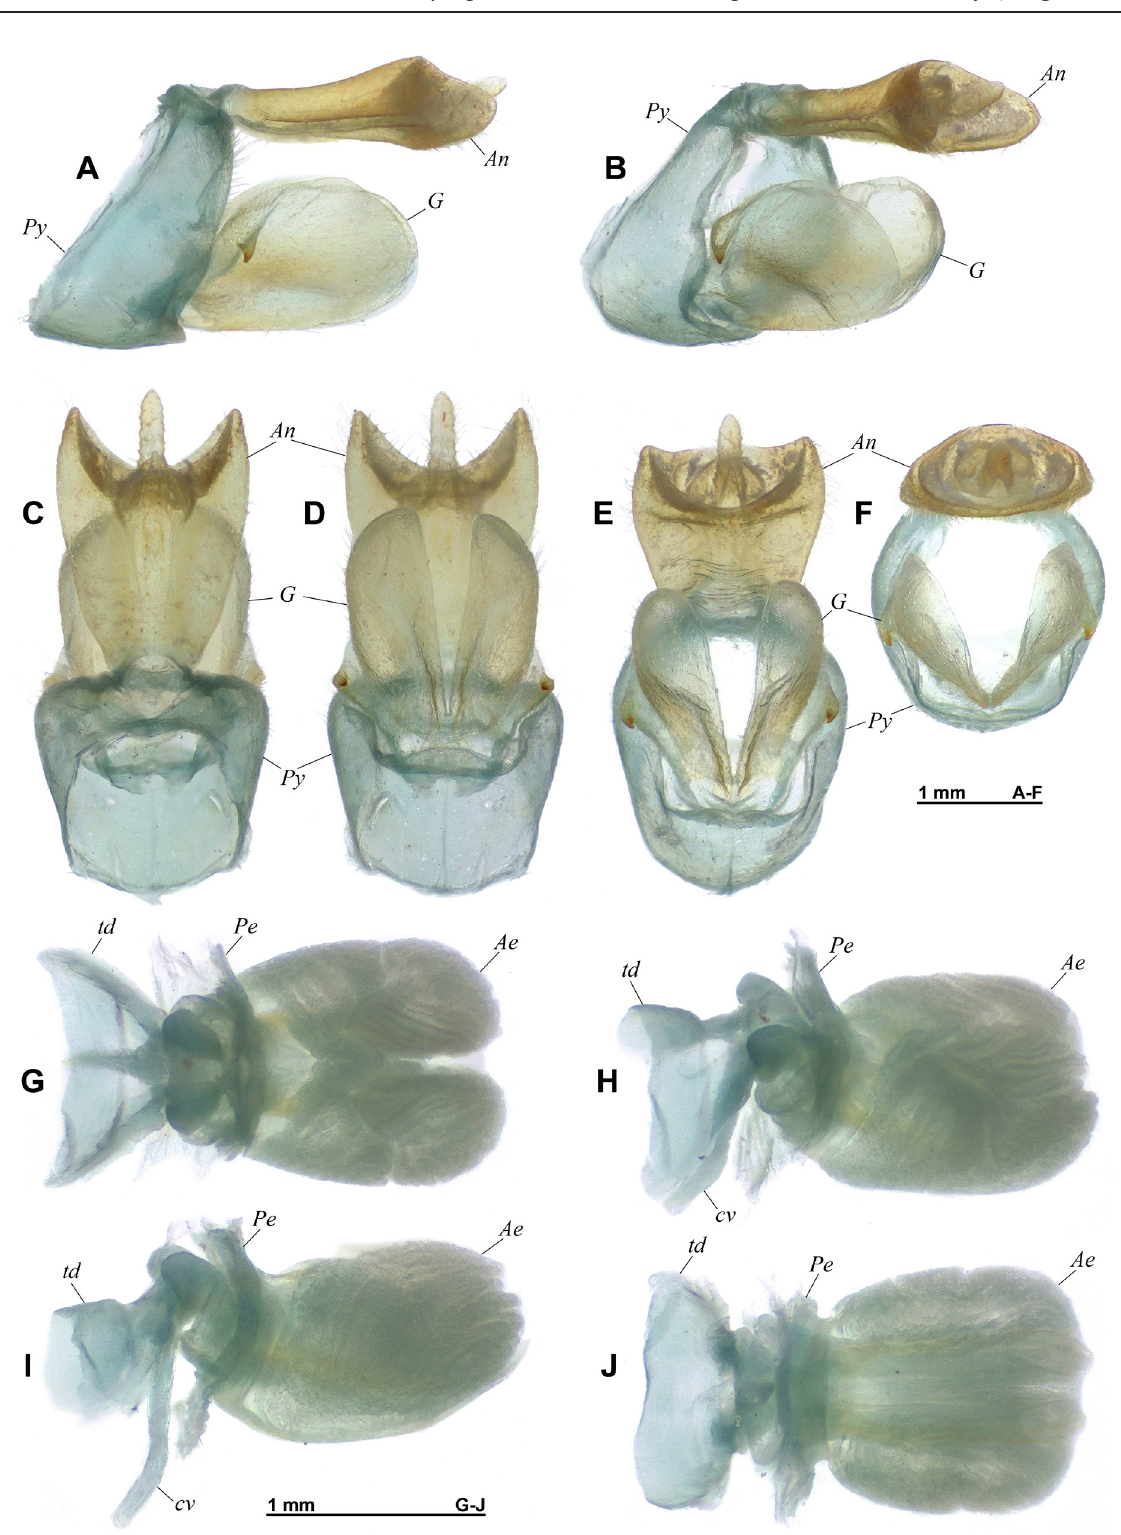
Fig. 2. Pyrops buomvoi sp. nov., holotype, male genitalia (VNMN). A–F . Pygofer, anal tube and gonostyli. A . Lateral view. B . Posterolateral view. C . Dorsal view. D . Ventral view. E . Posteroventral view. F . Caudal view. G–J . Aedeagus. G . Dorsal view. H . Laterodorsal view. I . Lateral view. J . Ventral view. An = anal tube; Ae = aedeagus; cv = connective; G = gonostyli; Pe = periandrium; Py = pygofer; td =